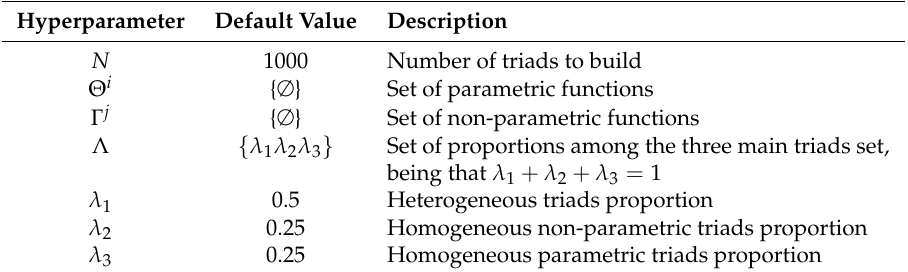
Table 2. Ensemble Triads